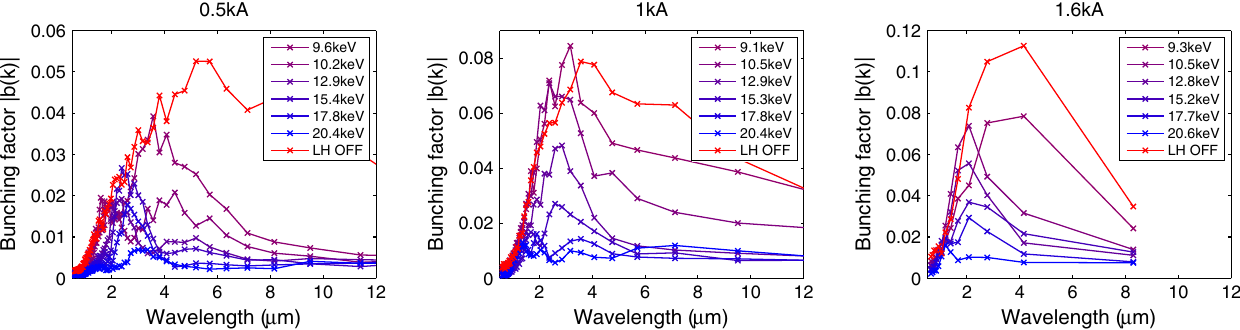
FIG. 4. Bunching factor as a function of energy spread induced by the laser heater for peak currents of 0.5 kA (left), 1 kA (center), and 1.6 kA (right). Each curve is a 30 shot average with ∼ 20% error bars (not shown for clarity). Vertical scale changes depending on bunch length (and hence current) because of the short MBI coherence length. Note that laser heater conditions were different for data shown in Fig. 2. Experimental details in the Appendix.